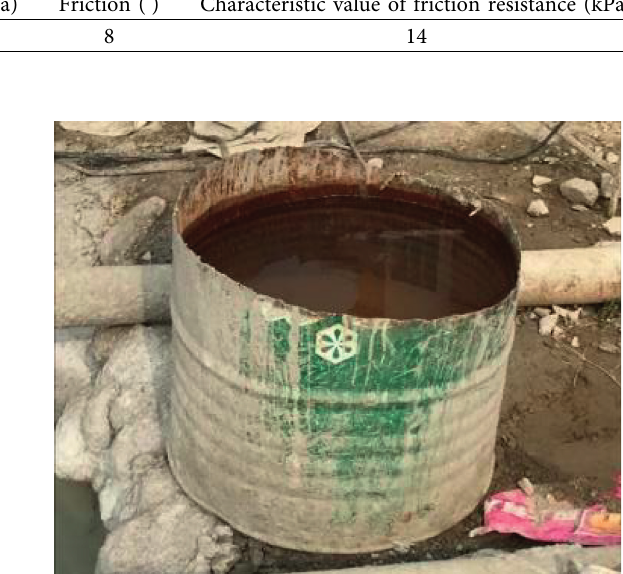
Figure 12: The water storage tank.